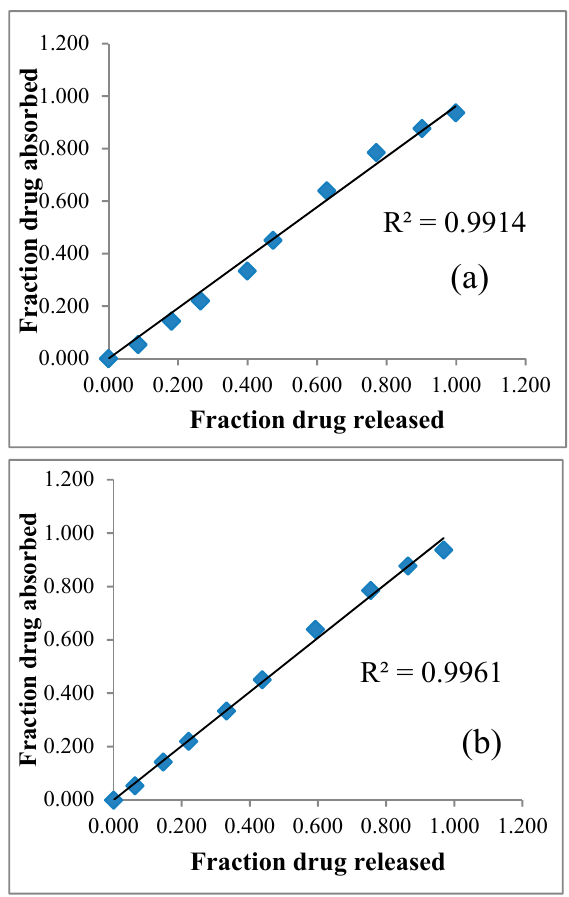
Figure 12. Level A IVIVC for ( a ) RGM-6 P ( b ) RGM-6 B. Figure12. Level A IVIVC for ( a ) RGM-6 P ( b ) RGM-6 B.